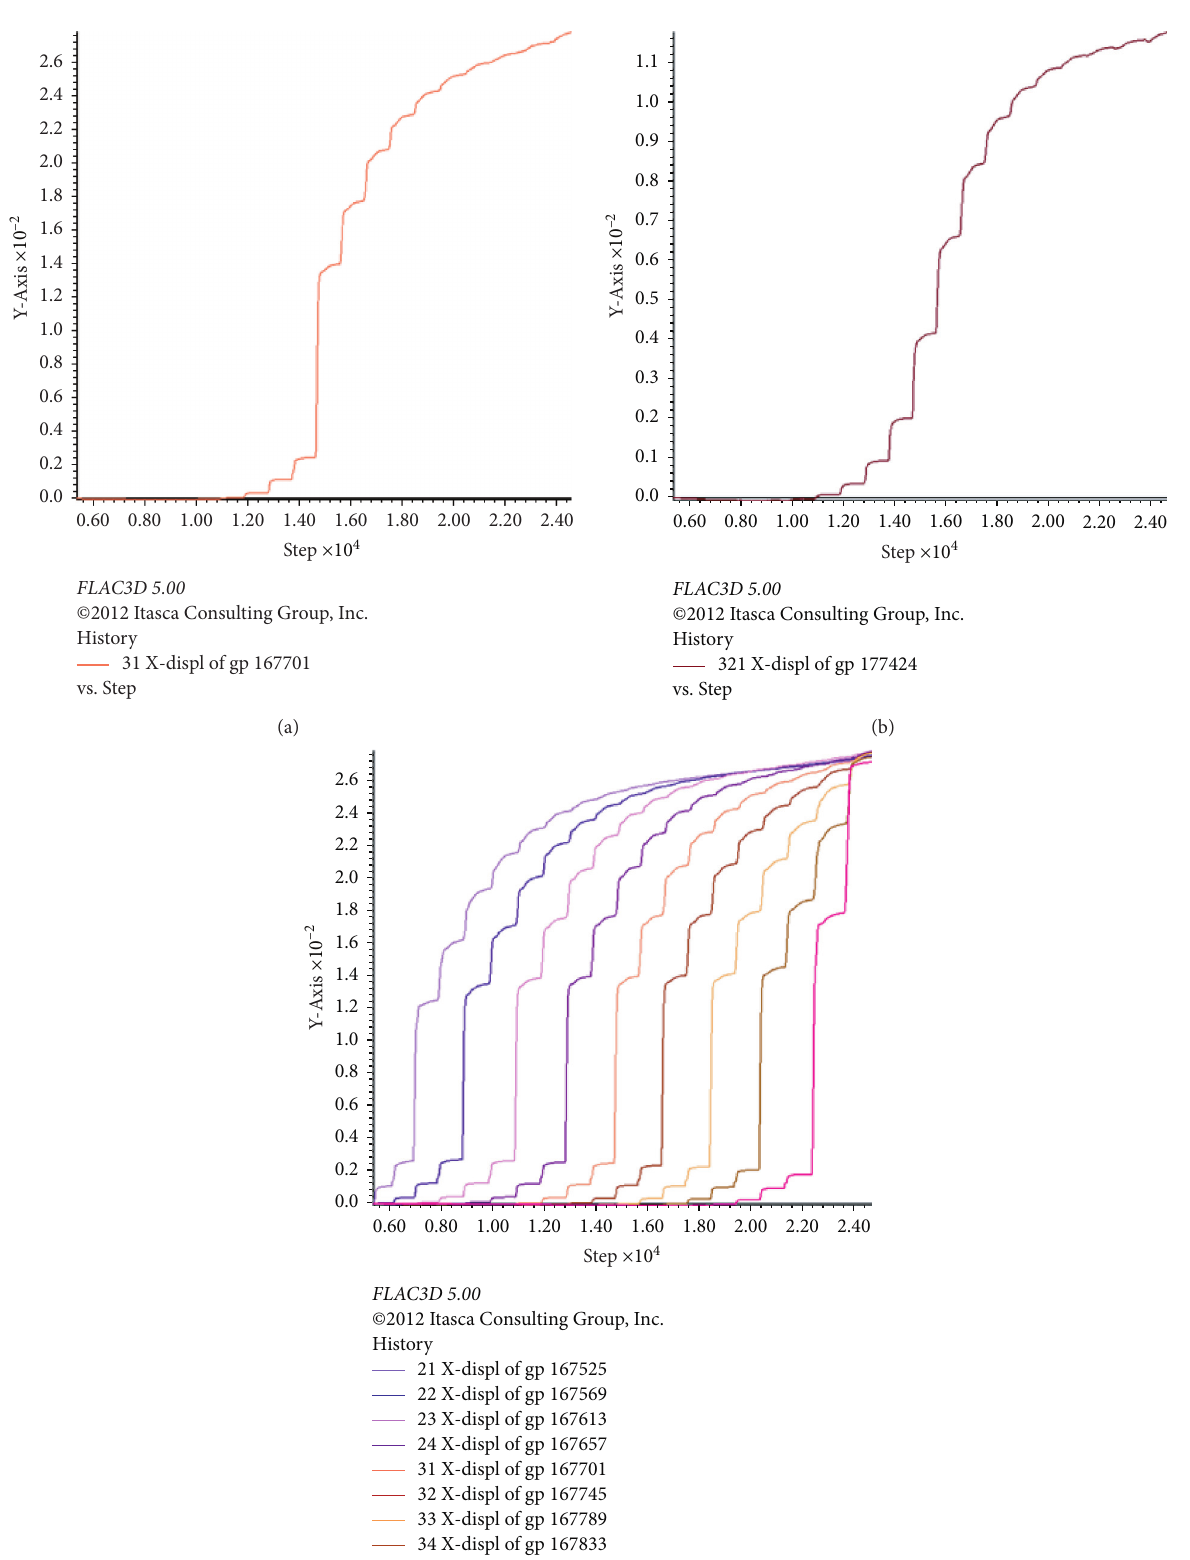
Figure 9: Horizontal displacement curve of tunnel sides: (a) displacement variation curve of the left side wall, (b) displacement variation curve of 1m depth in the left side wall, and (c) displacement variation curve of the monitoring